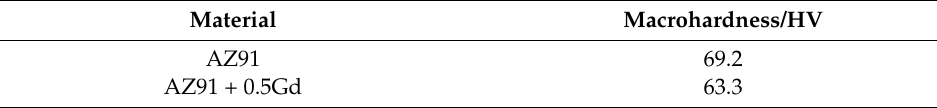
Table 3. Macro hardness of surfacing magnesium alloys.